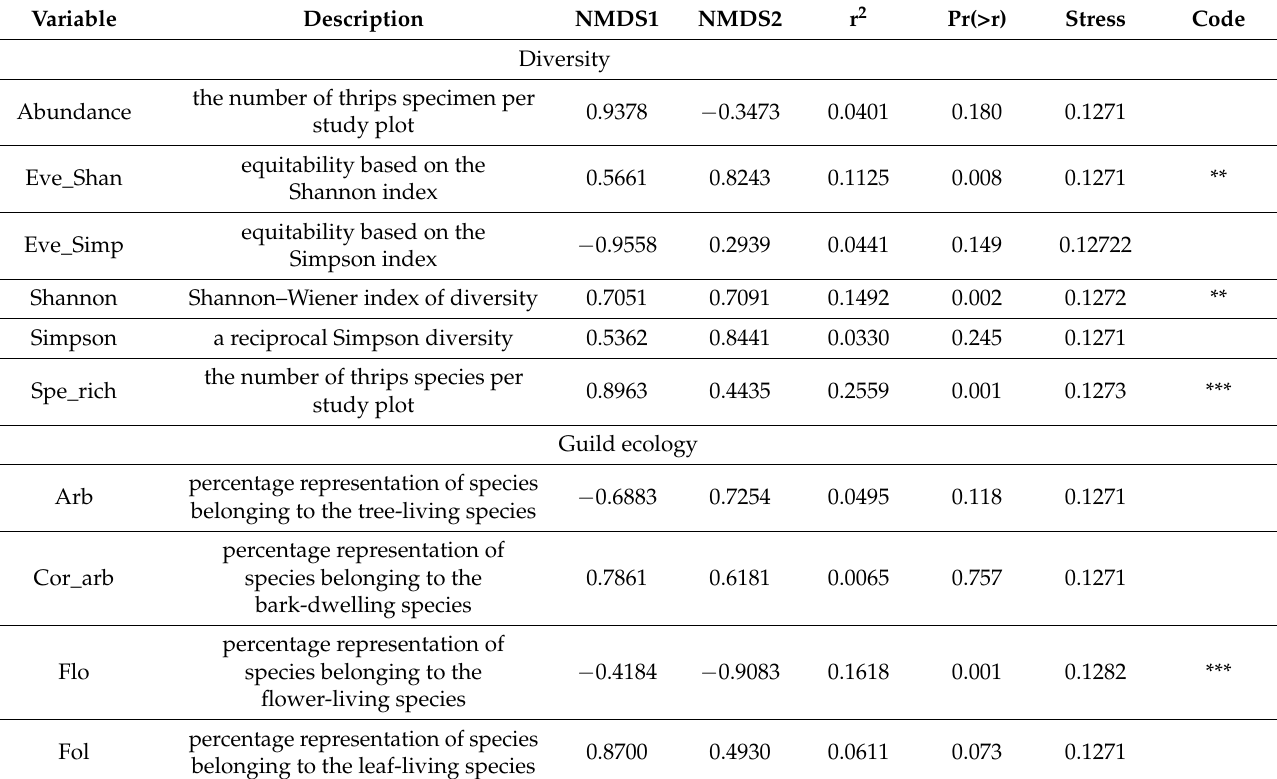
Table 2. Description of the analyzed variables and statistical